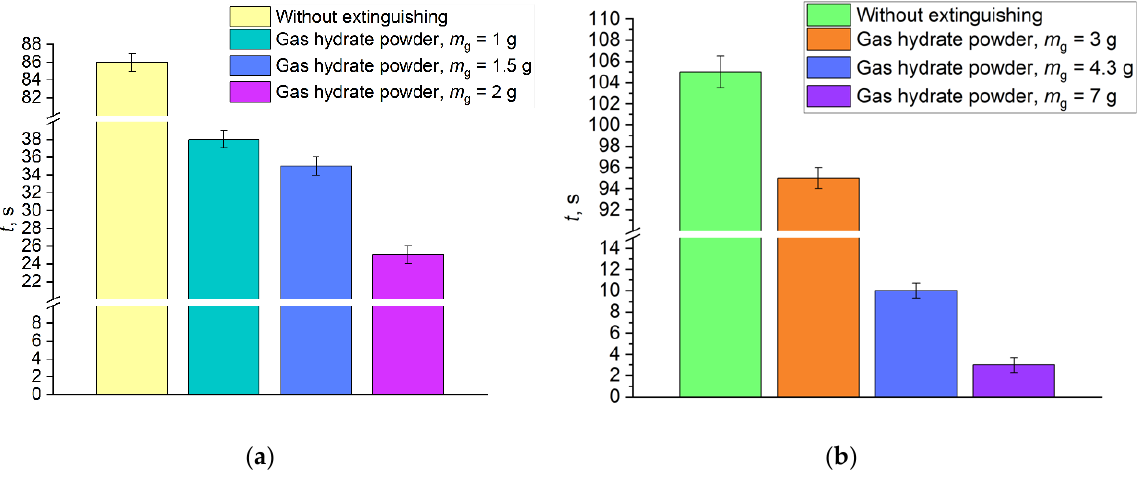
Figure 5. Extinction times of gasoline with varying initial volume ( V 0 ) burning when no extinguishing agents were used and when in contact with CO 2 hydrate powder with varying initial mass m g : ( a ) V 0 ≈ 3 mL; ( b ) V 0 ≈ 6 mL.